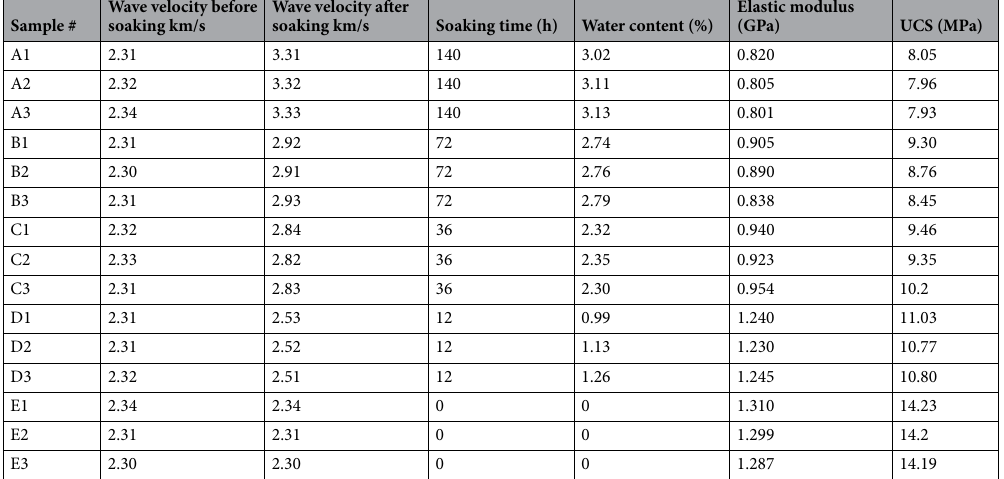
Table 1. The different characteristics of coal samples.